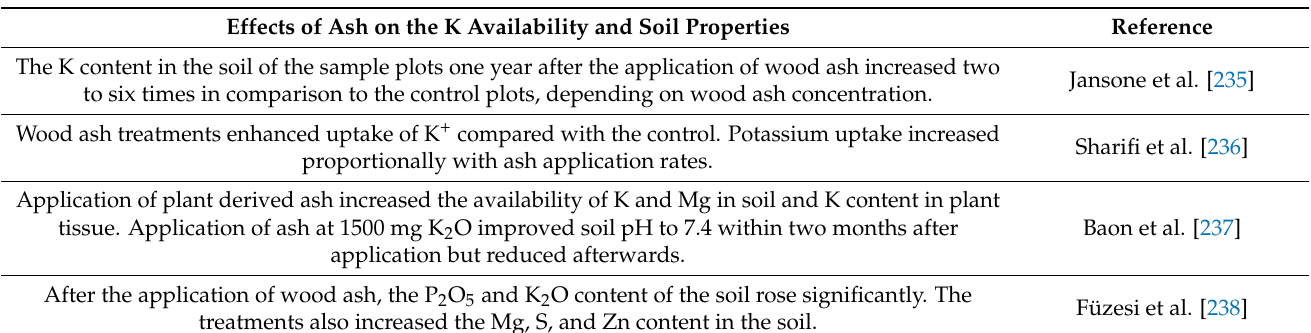
Table 4. Wood ash application on the potassium availability in acid